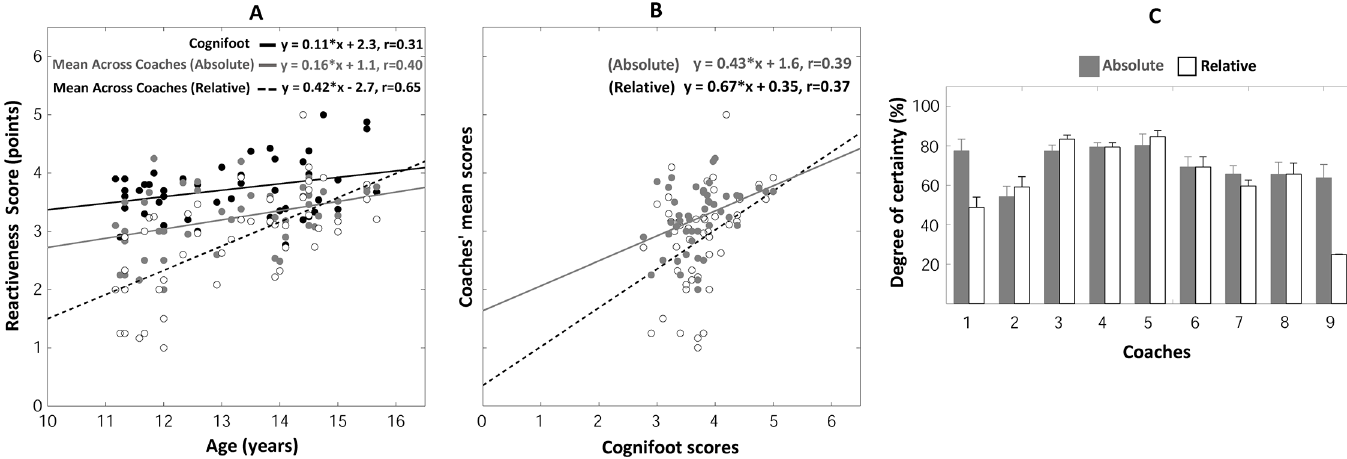
Fig 7. Reactiveness scores as a function of age, measuredby the Cognifootsystem or judgedby coaches (A)—Cognifoot scores vs mean coaches’scores (B) Degrees of certainty of the coaches in their -passingaccuracy- judgments (C).